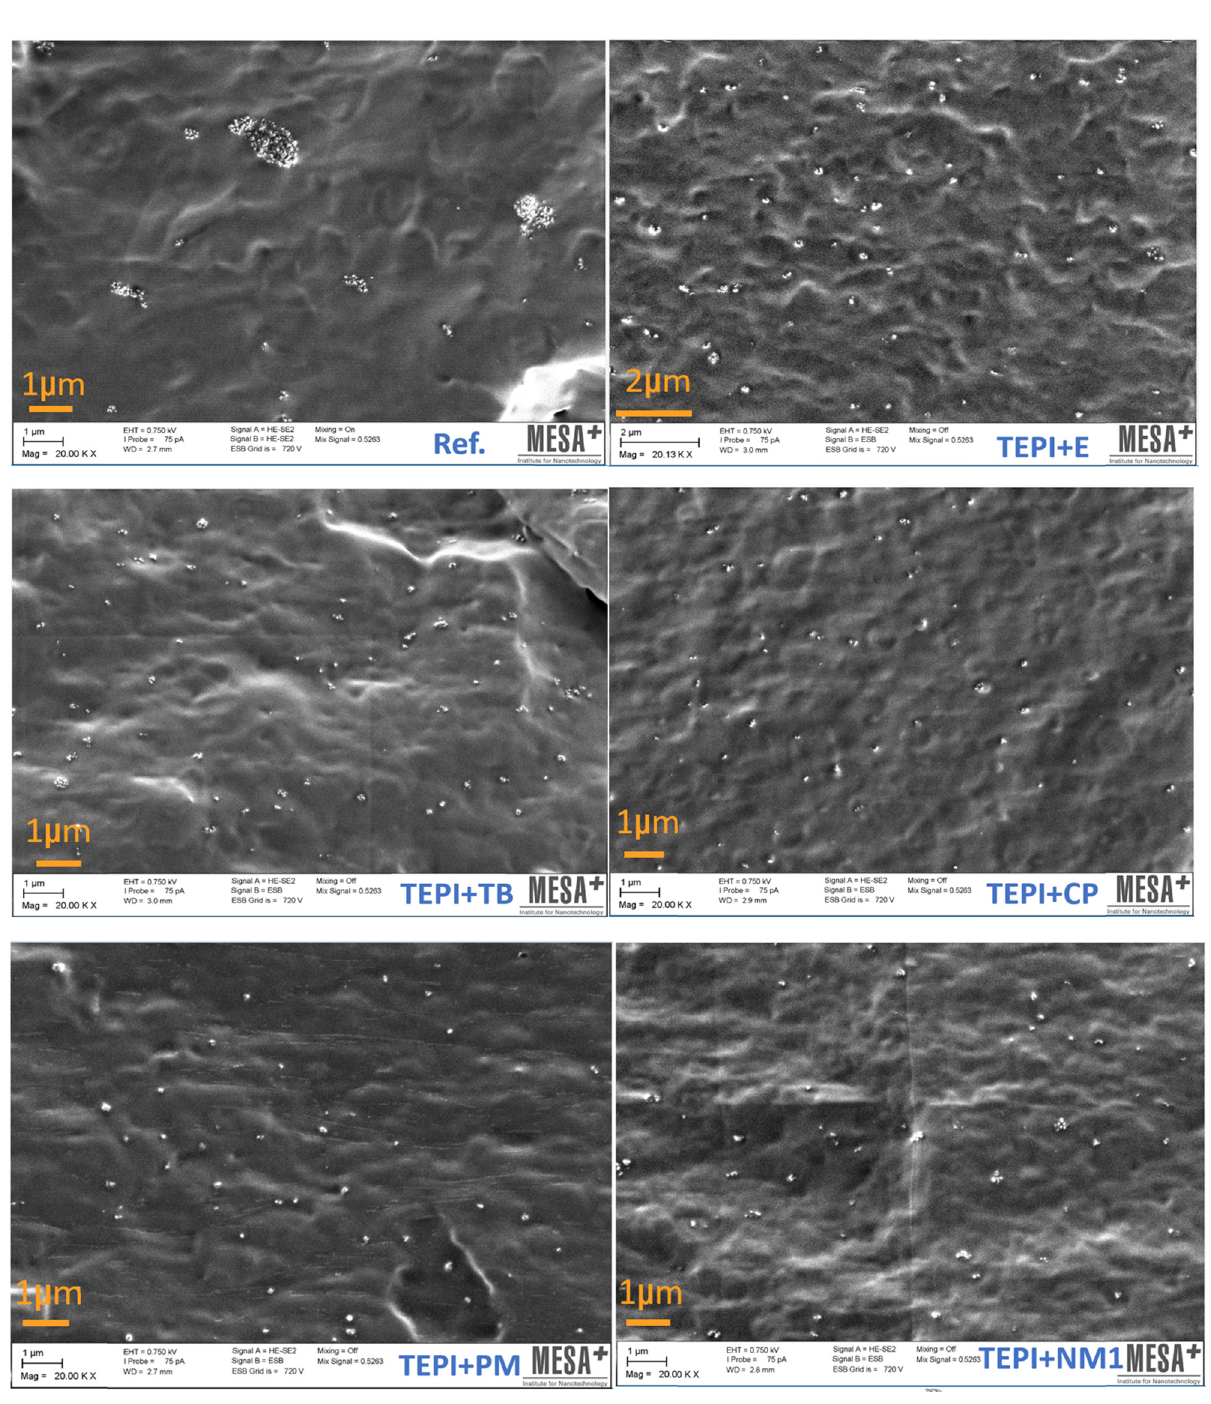
Figure 10: SEM images of nanocomposites fi lled with reference silica or modi fi ed